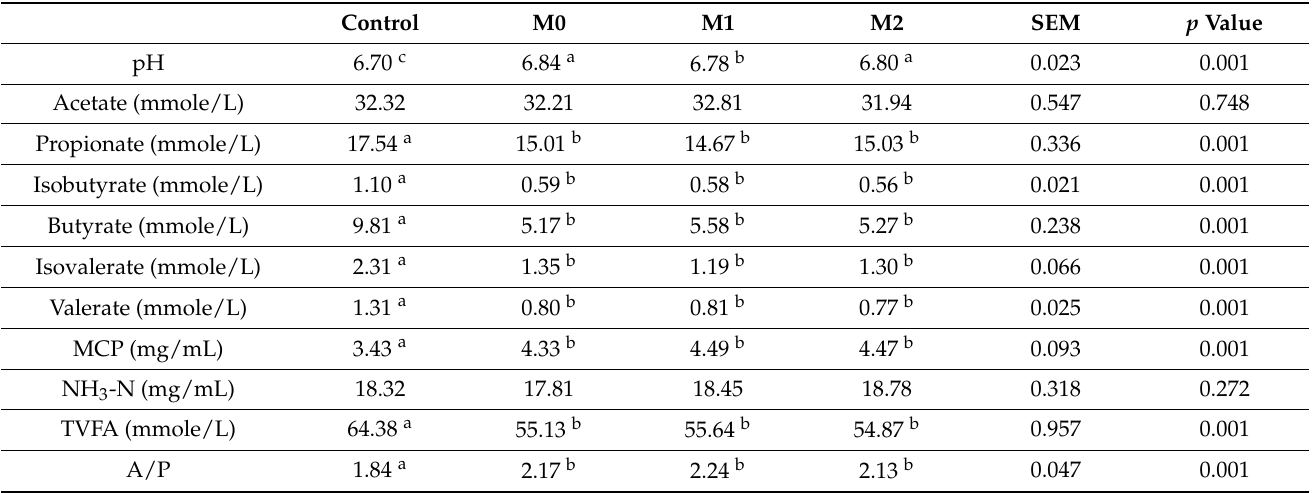
Table 4. In vitro rumen fermentation parameters.